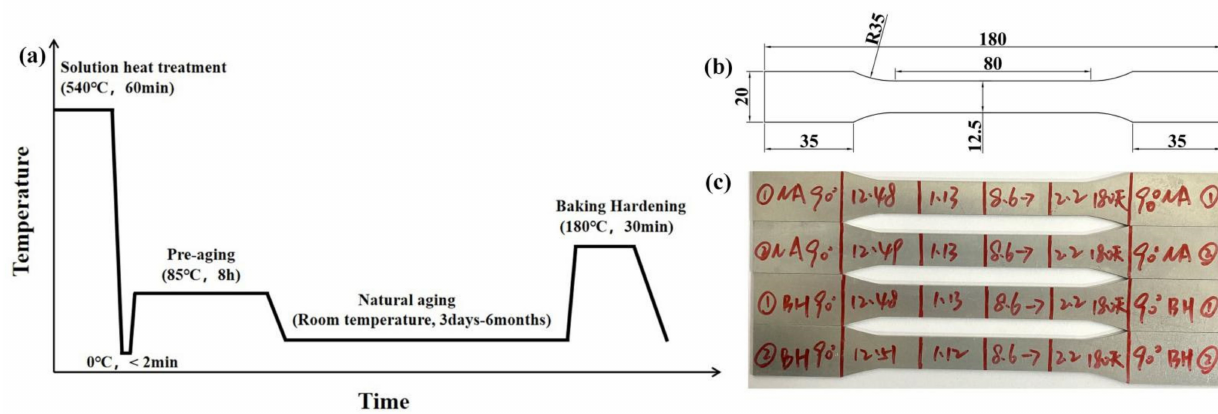
Figure 1. Schematic diagram of heat treatment process ( a ); specific size of the tensile sample in mm ( b ); and a group of tensile samples after NA for 180 days along 90 ◦ direction ( c ).